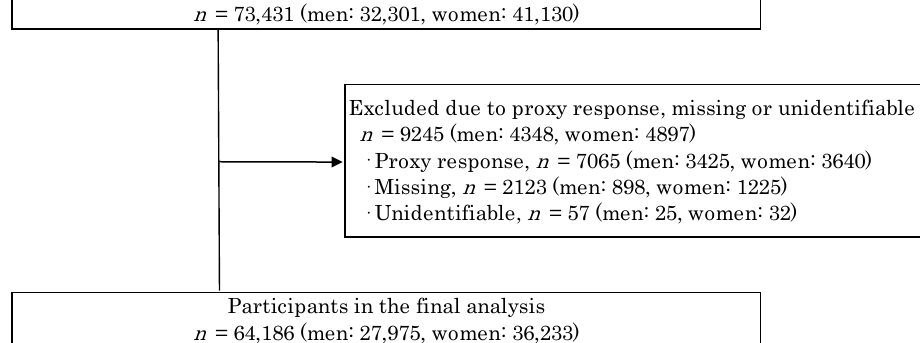
Figure 1. Flowchart of study participants after the Great East Japan Earthquake.